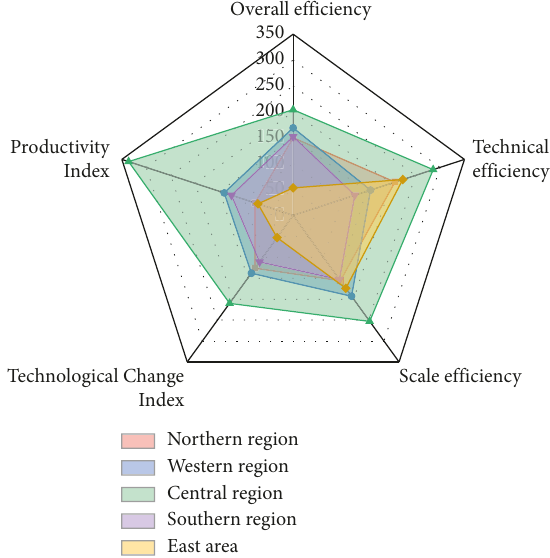
Figure 8: Distribution map of low carbon index in various